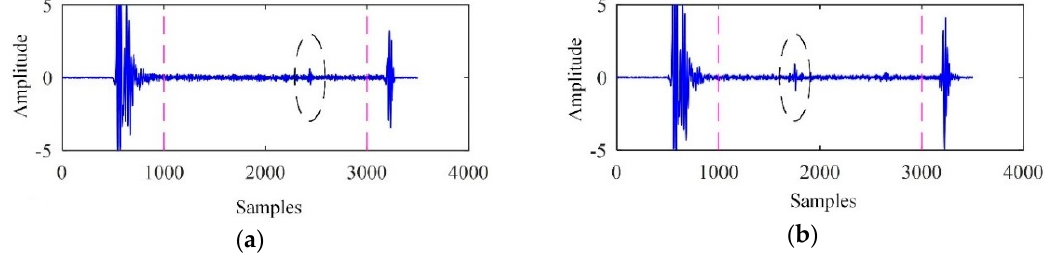
Figure 6. The ultrasonic signals. ( a ) Acquired from F1; ( b ) acquired from F2. Table 3. SampEn of the first five IMFs.